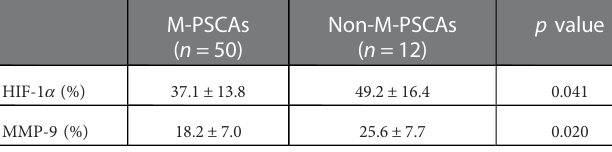
TABLE 6 Expression of hypoxia-inducing factor-1 α and matrix metalloproteinase-9 in middle cerebral arteries between M-PSCAs and non-M-PSCAs in moyamoya